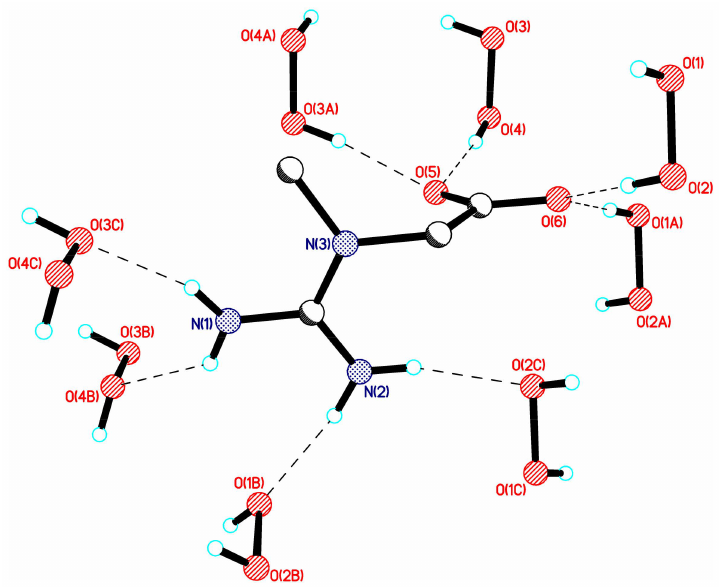
Figure 8. Hydrogen bonding of creatine in IV . Hydrogen bonds are shown by dashed lines. H 2 O 2 molecules adopt skew geometry (96.4(15) and 96.9(16) ◦ ) with O-O bond lengths equal to 1.4602(11) and 1.4643(10) Å. They both are involved in two donor HOOH ··· − O 2 C- and two acceptor NH ··· O 2 H 2 hydrogen bonds. In the crystal, creatine and peroxide molecules are combined in a complex 3D hydrogen-bonded motif (Figure 9).